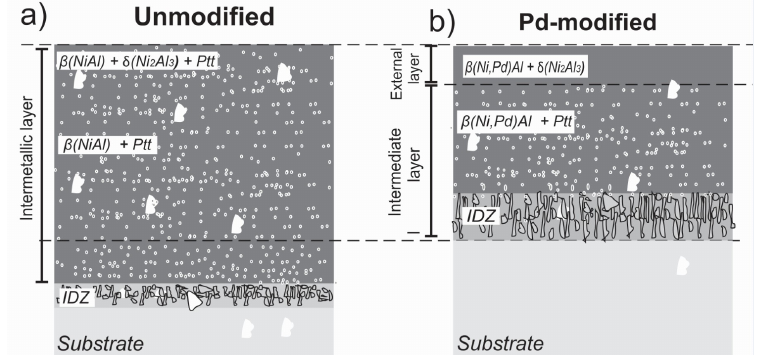
Figure 3. Schematic representation highlighting the different microstructures for aluminized coatings: a) unmodified; b) Pd-modified.